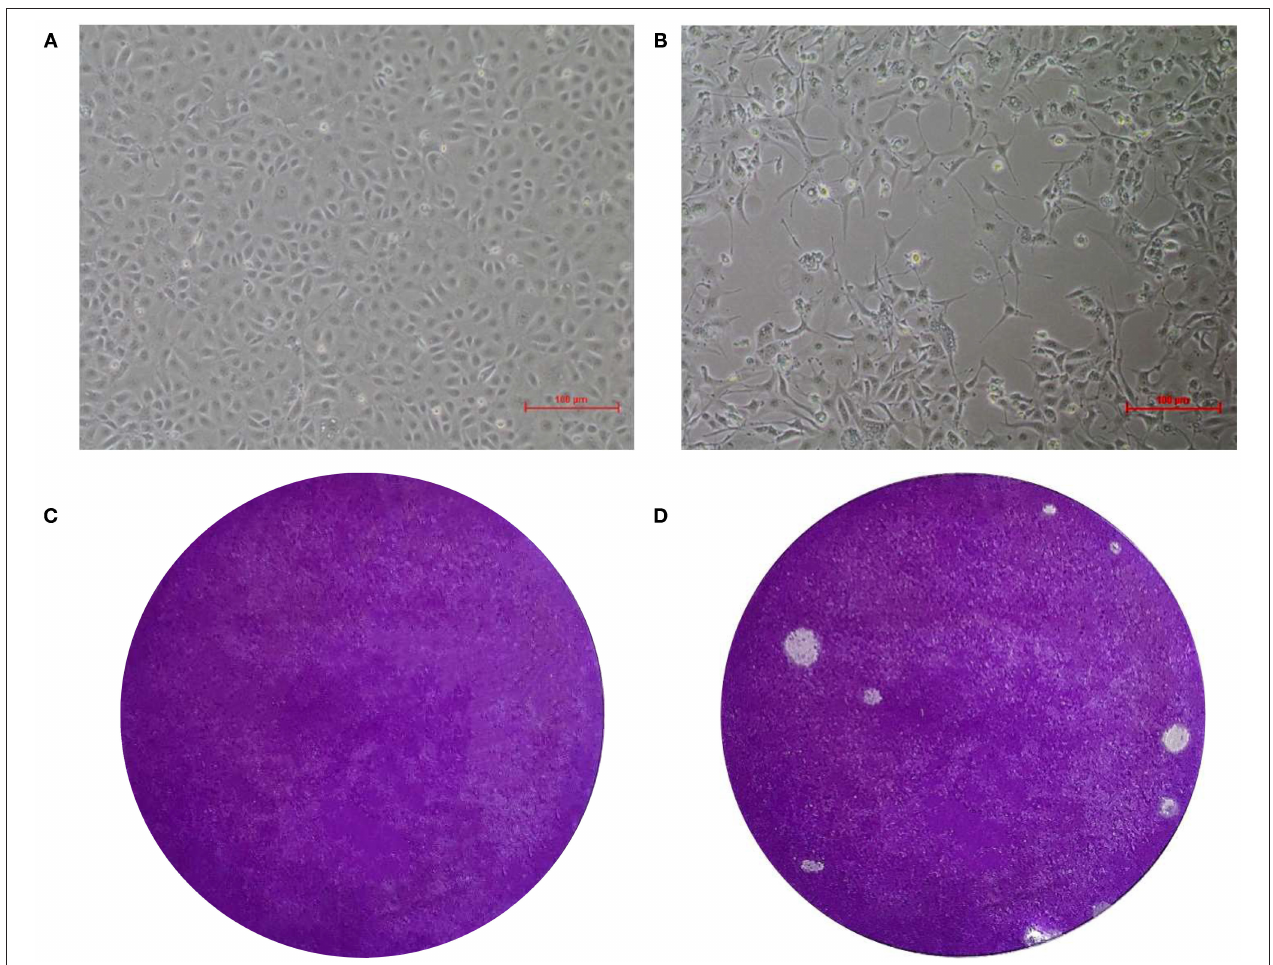
FIGURE 1 | CPE and plaque formation of the EV-G CH/17GXQZ/2017 strain. Neither CPE nor viral plaques were observed in the mock cells (A,C) . CPE caused by the EV-G CH/17GXQZ/2017 strain in Marc-145 cells was characterized by cell shrinkage, rounding and detachment at 48 hpi (200 × magnification) (B) . Viral plaques of EV-G isolates of CH/17GXQZ/2017 developed at 4 dpi (D)